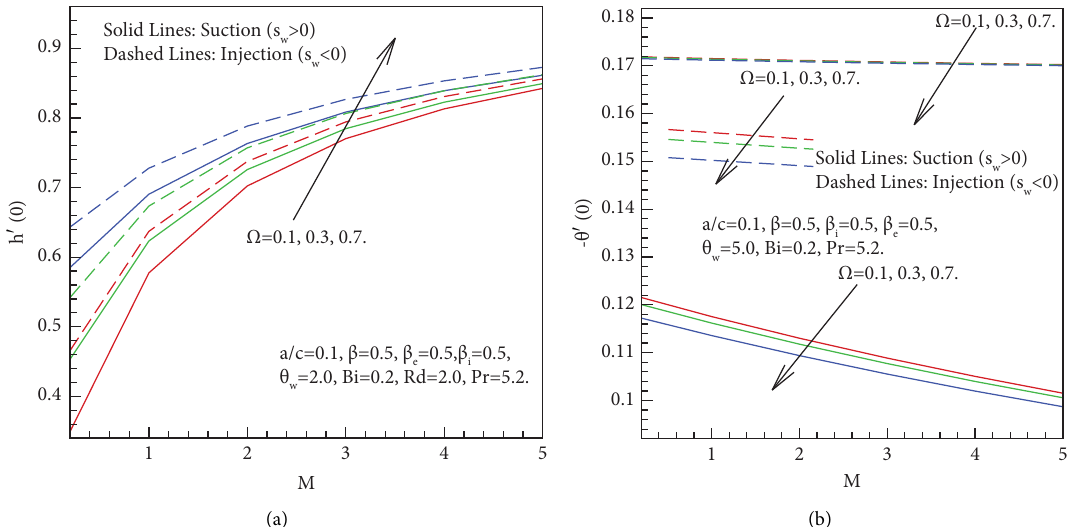
Figure 7: (a) Tangential skin friction at surface − h ′ ( 0 ) and (b) heat fux − θ ′ ( 0 ) for permeability parameter Ω against magnetic feld parameter M .